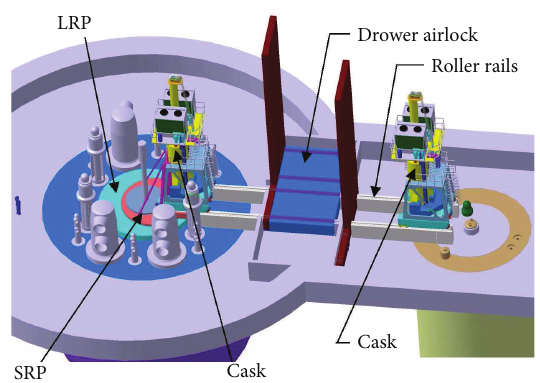
Figure 13: Main components of the Bertin/CNIM fuel handling route.